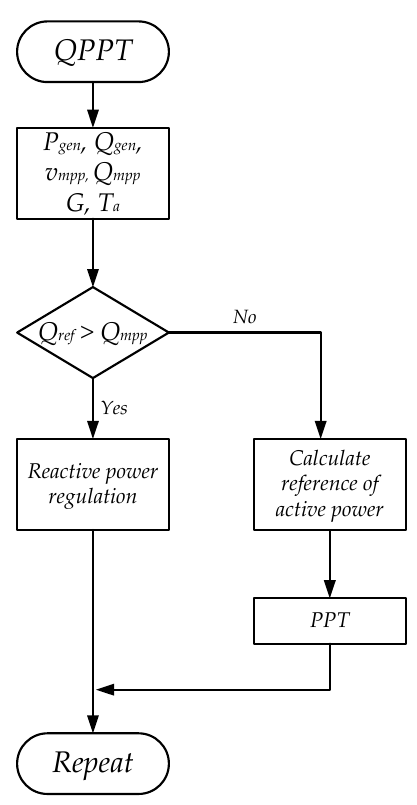
Figure 18. Logic of control for reactive power in PV generators.